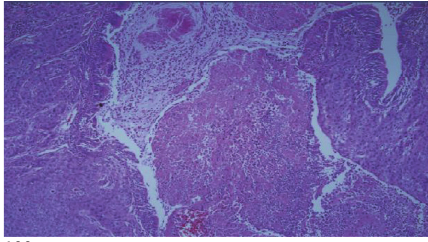
Figure 6: SCC invasion of bronchus. Note the intact pseudostrat- ified ciliated columnar epithelium of the bronchial wall to the left and upper right of the image, while the lower right portion shows the tumor breaking through the bronchial wall and invading the bronchial lumen.